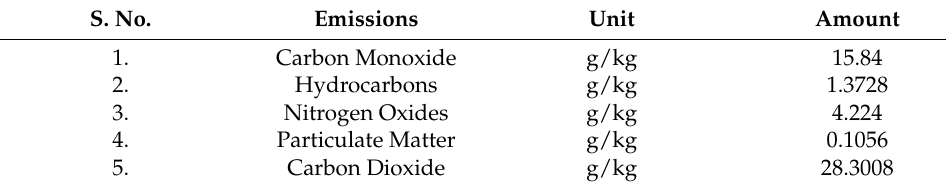
Table 5. Total amount of emissions generated for 1 L of ship fuel